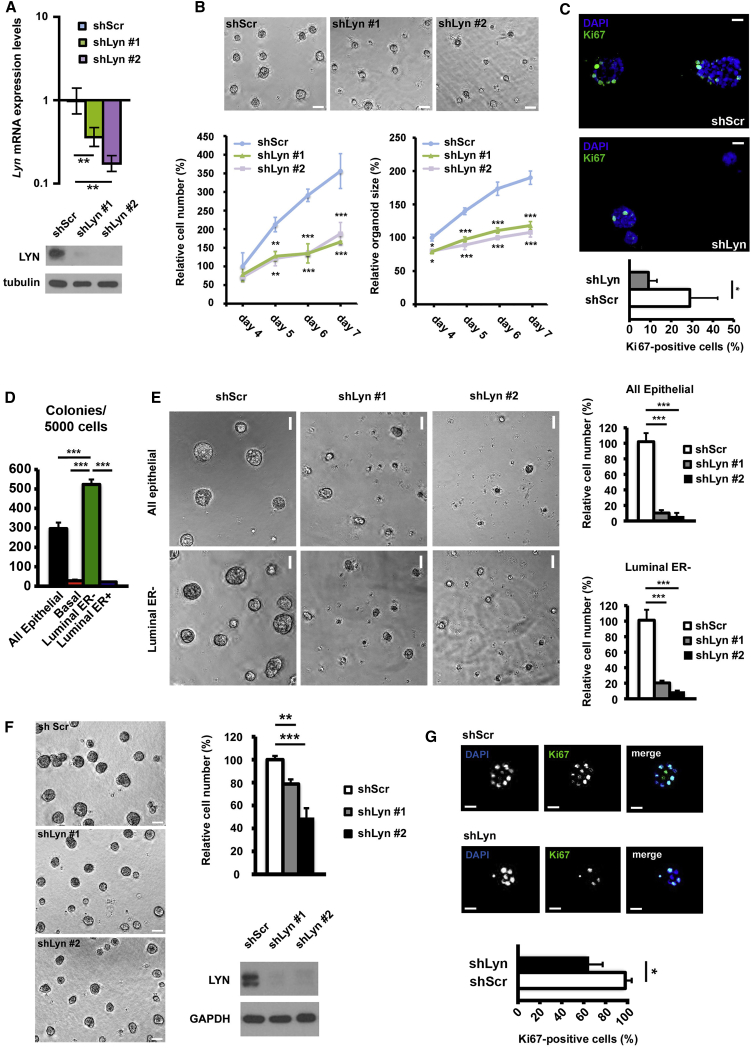
LYN Promotes Normal Mammary Cell Growth(A) Analysis of Lyn expression levels by qRT-PCR relative to shScr cells (top) and western blot (bottom) in primary mouse mammary organoids 4 days after transduction with control (shScr) or Lyn knockdown (shLyn1 and shLyn2) lentiviruses.(B) Growth of mammary organoids after transduction with control (shScr) or Lyn knockdown (shLyn1 and shLyn2) lentiviruses, assessed by cell number change (left bottom panel) or organoid size (right bottom panel) relative to shScr cells, day 4 after plating. Top panels: representative images show organoids at day 6 of culture. Scale bar, 75 μm.(C) Ki67 immunofluorescence staining (green) of control (shScr)- and shLyn-carrying mammary organoids 6 days after lentiviral transduction (DAPI nuclear counterstaining). Representative images and quantification of the percentage of Ki67-positive cells. Scale bar, 20 μm.(D) Colony-forming potential of unfractionated primary mammary epithelial cells (all epithelial) or basal, luminal ER−, and luminal ER+ subpopulations. 5,000 cells from each fraction were plated on Matrigel, and colony numbers were determined after 12–14 days.(E) Growth inhibition of unfractionated primary mammary epithelial cells (all epithelial) or the luminal ER− fraction transduced with control (shScr) or Lyn knockdown (shLyn1 and shLyn2) lentiviruses and seeded onto Matrigel. Cell growth was assessed after 12–14 days. Representative images, left (scale bar, 100 μm); quantitation, right.(F) Growth inhibition of MCF10A cells transduced with lentiviral vectors carrying control shRNA (shScr) or shRNA against LYN (shLyn1 and shLyn2). Transduced cells were grown in 3D on Matrigel, and relative cell numbers were assessed after 12 days of culture. Representative images of acinar structures (day 12) derived from shScr, shLyn1, or shLyn2 cells are shown (scale bar, 100 μm), together with CellTiterGlo quantitation and assessment of LYN knockdown by western blot (GAPDH loading control).(G) Confocal microscope analysis of Ki67 immunofluorescence-stained shScr, shLyn1, or shLyn2 knockdown MCF10A cells at day 4 of culture in 3D with quantitation. DAPI was used for counterstaining. Scale bar, 20 μm.Blots are representative of three independent experiments. Quantitation, mean and SD (n = 3; two-tailed unpaired t tests) except for gene expression analysis by quantitative real-time RT-PCR (mean ± 95% confidence intervals; significance of real-time RT-PCR data was determined from confidence intervals; n = 3 independent experiments for each of 3 technical replicates per sample) (Cumming et al., 2007). ∗p < 0.05; ∗∗p < 0.01; ∗∗∗p < 0.001. See also Figures S1–S3.